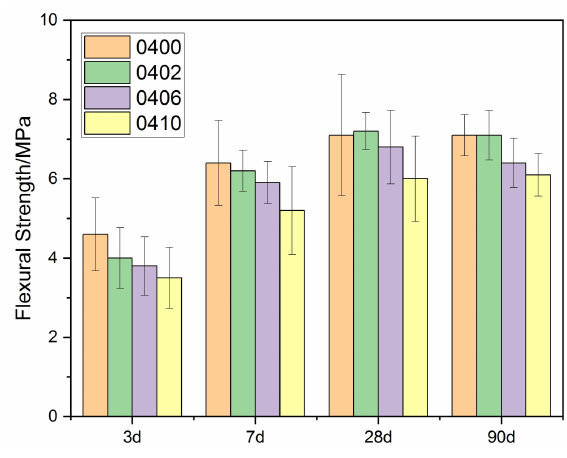
Figure 5. Flexural strength of cement paste (W/C = 0.4) with